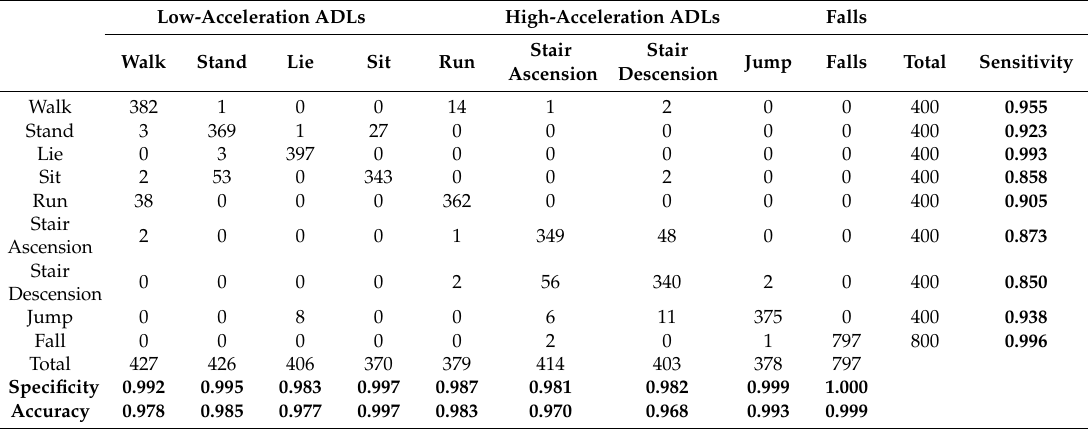
Table 5. 9 × 9 confusion Table for low-, high-acceleration ADLs and fall